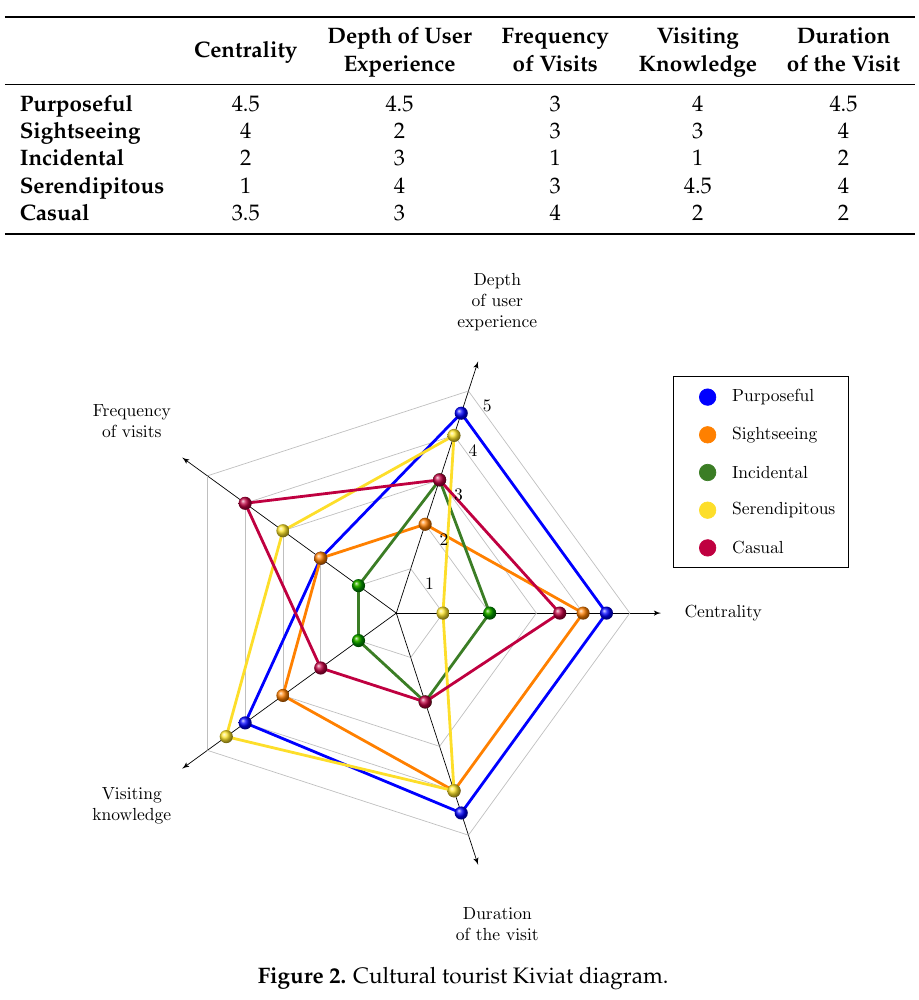
Table 4. Cultural tourist rating.